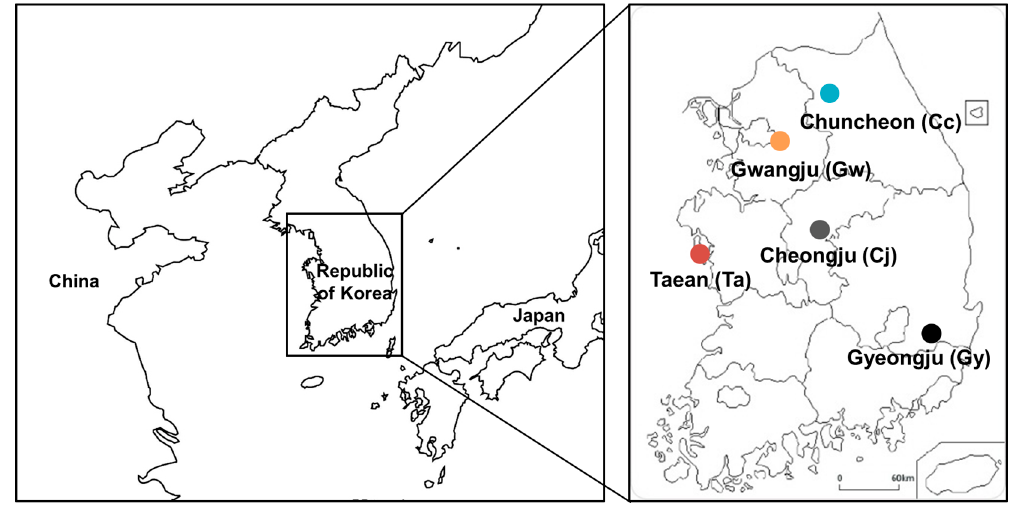
Figure 1. Study sites of soil conditioning for recovery from acidification.